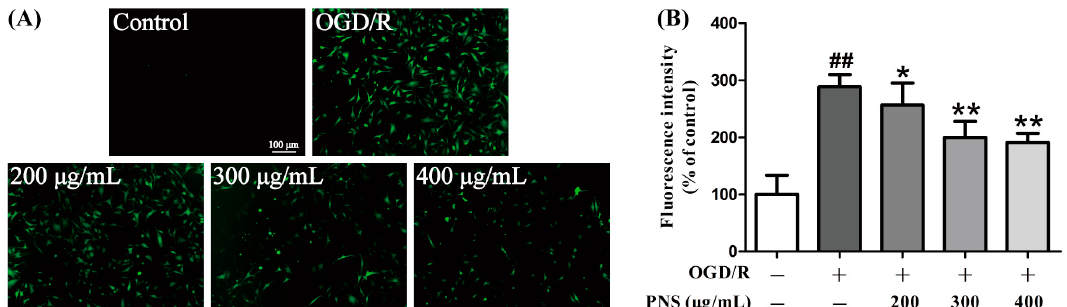
Figure 3. The inhibitory effect of PNS on the OGD4h/R12h-induced ROS production. DCFH-DA, a fluorescent indicator, was used to visualize ROS, which was detected by fluorescence microscopy ( A ) and quantified by microplate reader ( B ). Data are expressed as mean ± SD (N = 6). ## p < 0.01 vs. Control group, * p < 0.05 and ** p < 0.01 vs. Model group. Scale bar = 100 μ m.